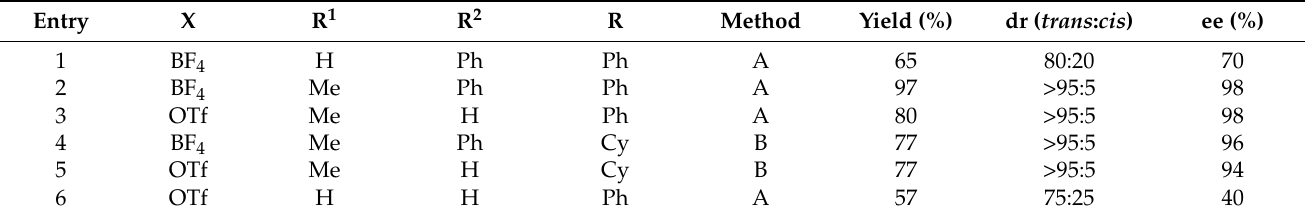
Table 3. Aggarwal asymmetric synthesis of vinyl epoxides using allyl sulfonium salt (Scheme 15).